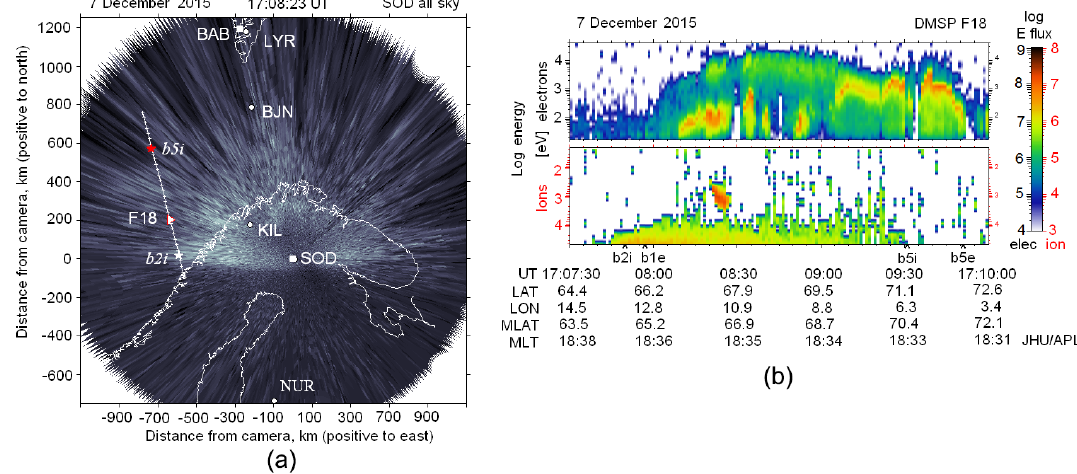
Figure 3. (a) Sodankylä (SOD) all-sky camera image at 557.7nm. North is at the top, and west is on the left. The DMSP F18 trajectory is mapped, and the triangle marks the location of the satellite at the time of the image. (b) DMSP spectrograms with the magnetospheric boundaries identified using the algorithms of Newell et al.